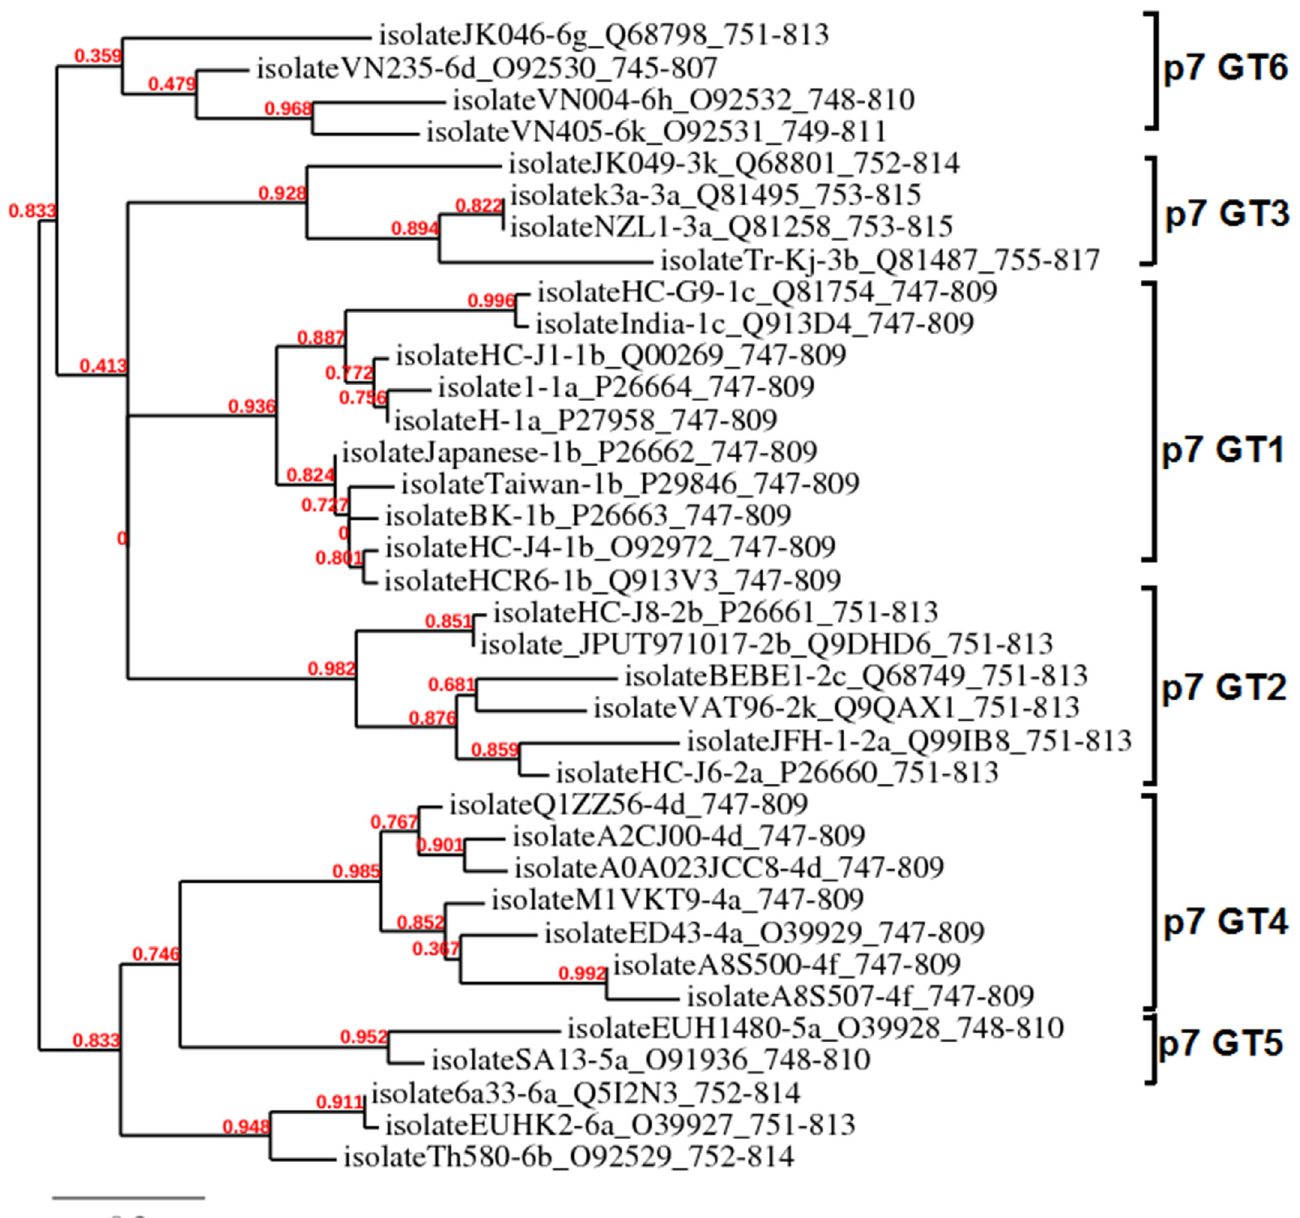
Fig 1. Phylogenetic relationships among different HCV genotypes and their subtypes. The numbers (shown in red) above the branches are the maximum likelihood branch support values that are obtained by using PhyML 3.0 program.